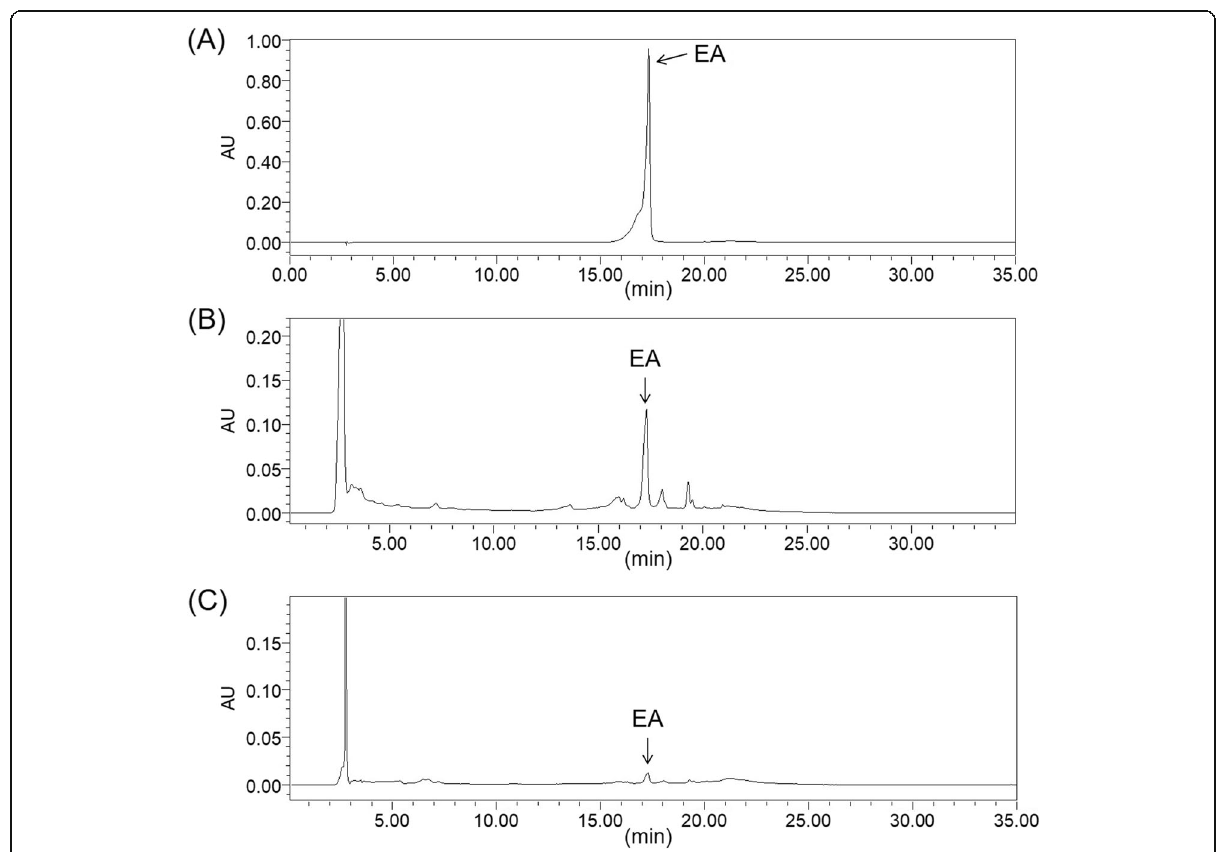
Fig. 5 Liquid chromatography (LC) chromatograms of mature and immature Rubus coreanus fruit (MRF and IRF, respectively). Chromatogram: ( a ) Ellagic acid (EA, 200 μ g/mL); ( b ) water extracts of MRF, 5 mg/mL; and ( c ) ethanol extracts of IRF, 5